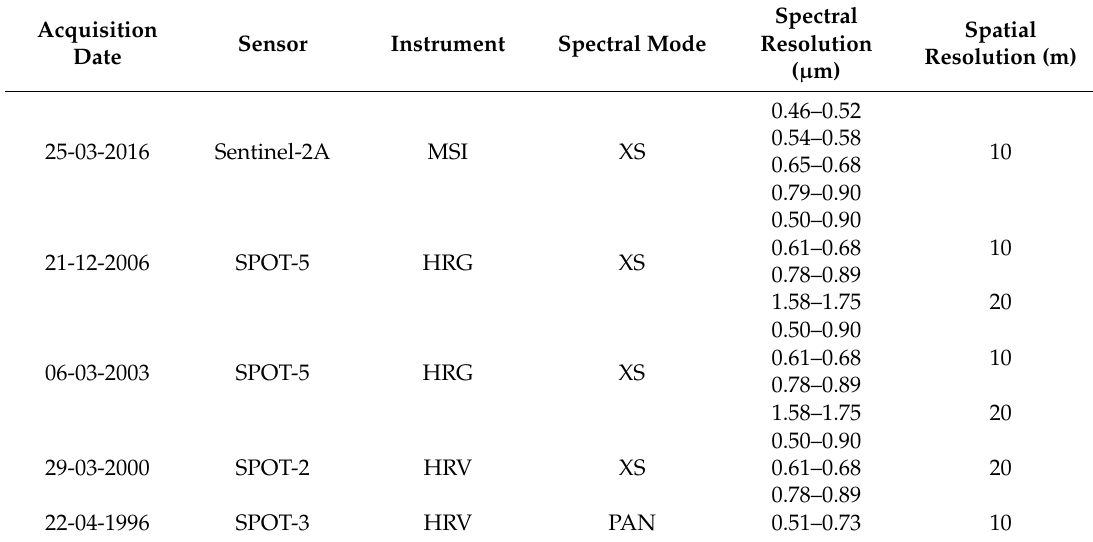
Table 1. Sensor system characteristics of remote sensing data used in this study.